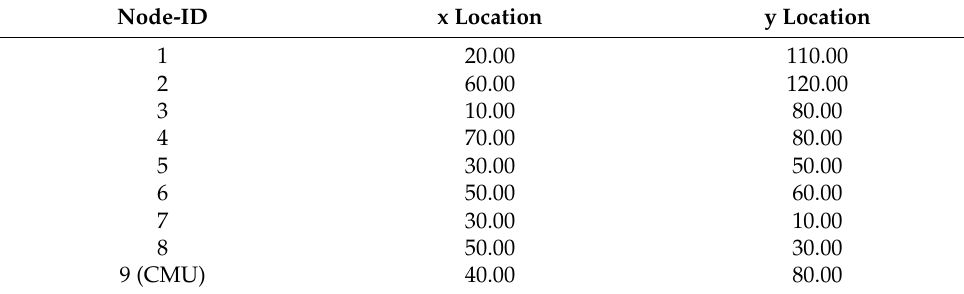
Table 2. Sensor node deployment in the region of interest.